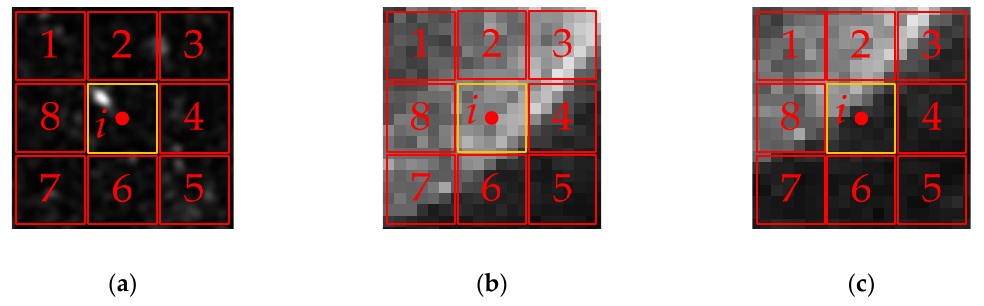
Figure 3. ( a ) The image patches with speckle; ( b ) The center pixel locates to the brighter side of the local region; ( c ) The center pixel locates to the darker side of the local region.